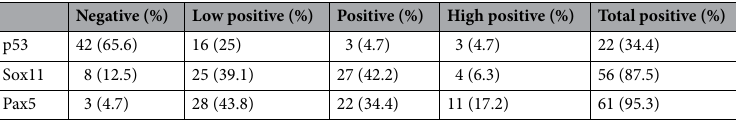
Table 2. Result of immunohistochemistry